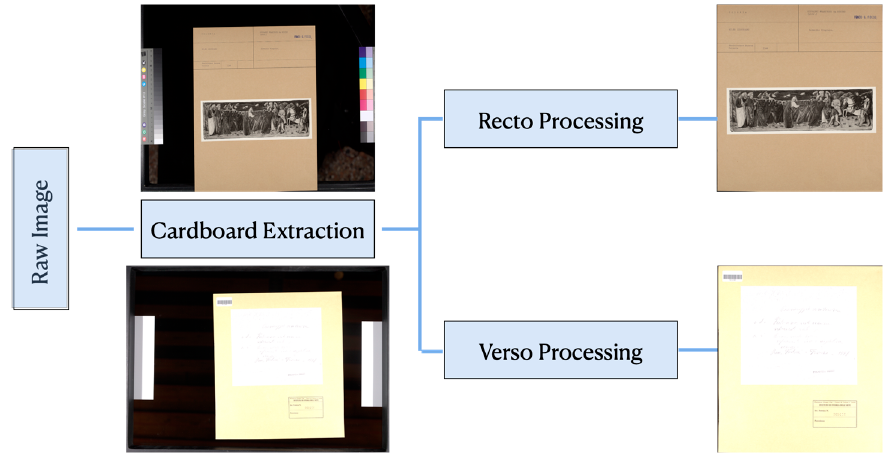
Figure 6. Schema of Recto and Verso Extraction Processing.